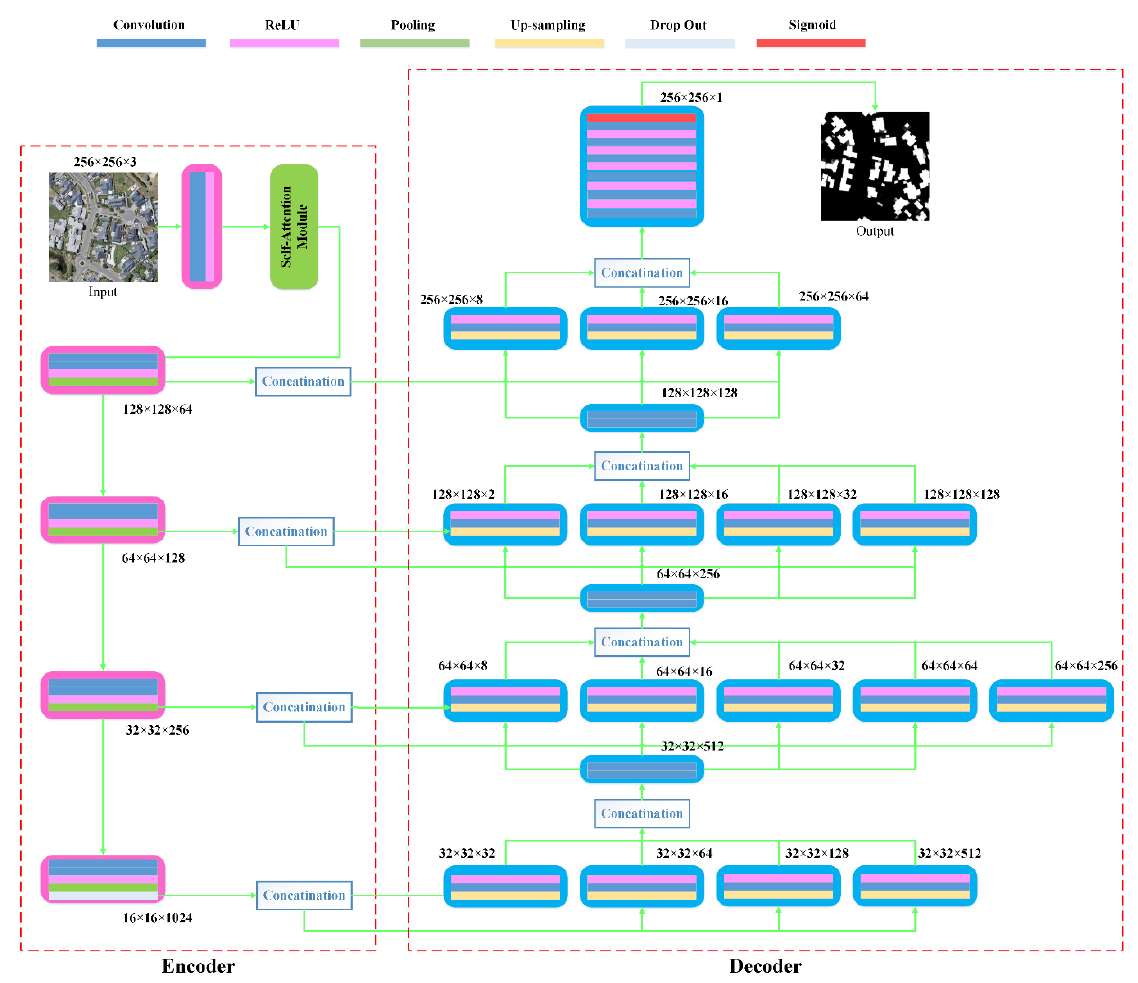
Figure 4. Detail architecture of our model.